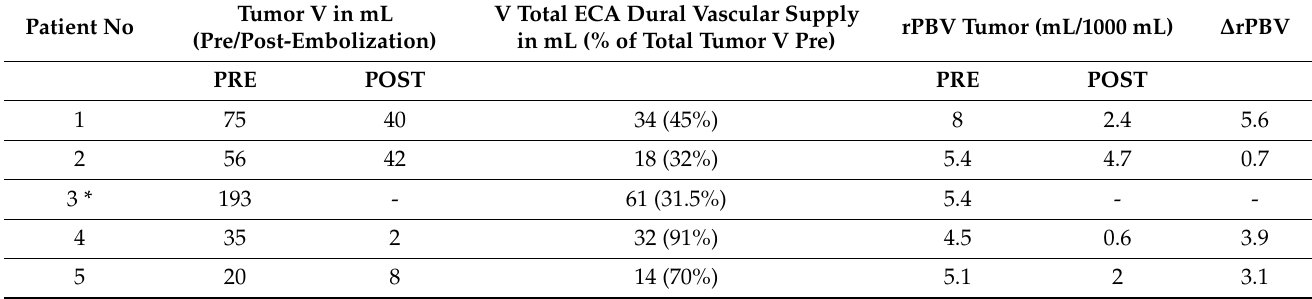
using an elliptical ROI in sagittal plane reformation ( E ). Table 2. An overview of tumor volume (mL) pre- and post-embolization, tumor volume (mL) supplied by dural arteries from the external carotid artery (ECA) and rPBV values with ∆ rPBV is